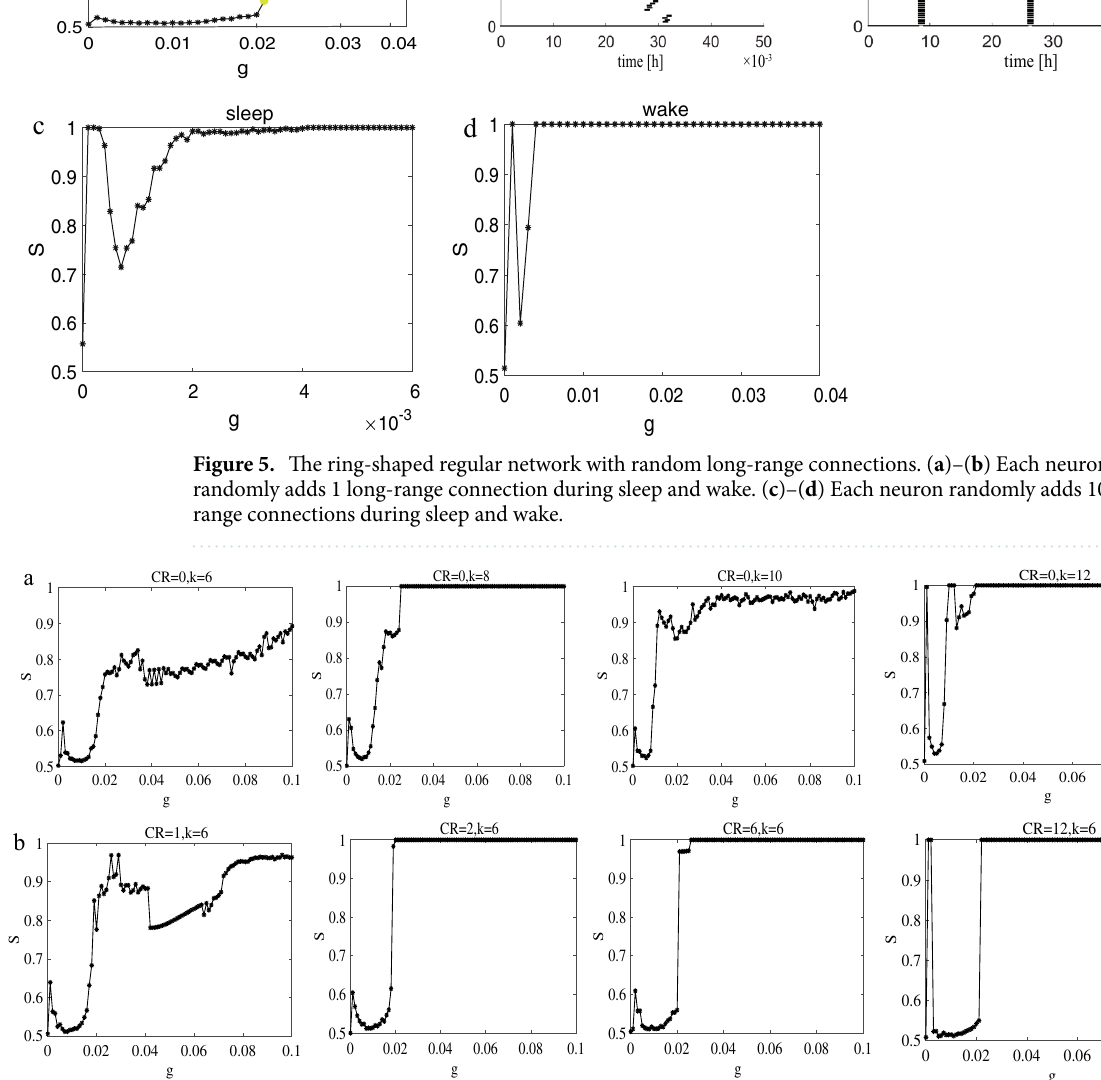
Figure 6. Effects of link density and long-range connections during wake. ( a ) The ring-shaped regular network with different edge density (from left to right is k = 6, k = 8, k = 10, k = 12 ). ( b ) The ring- shaped network with different long-range connections (the connection distance from left to right is CR = 1, CR = 2, CR = 6, CR = 12 ).